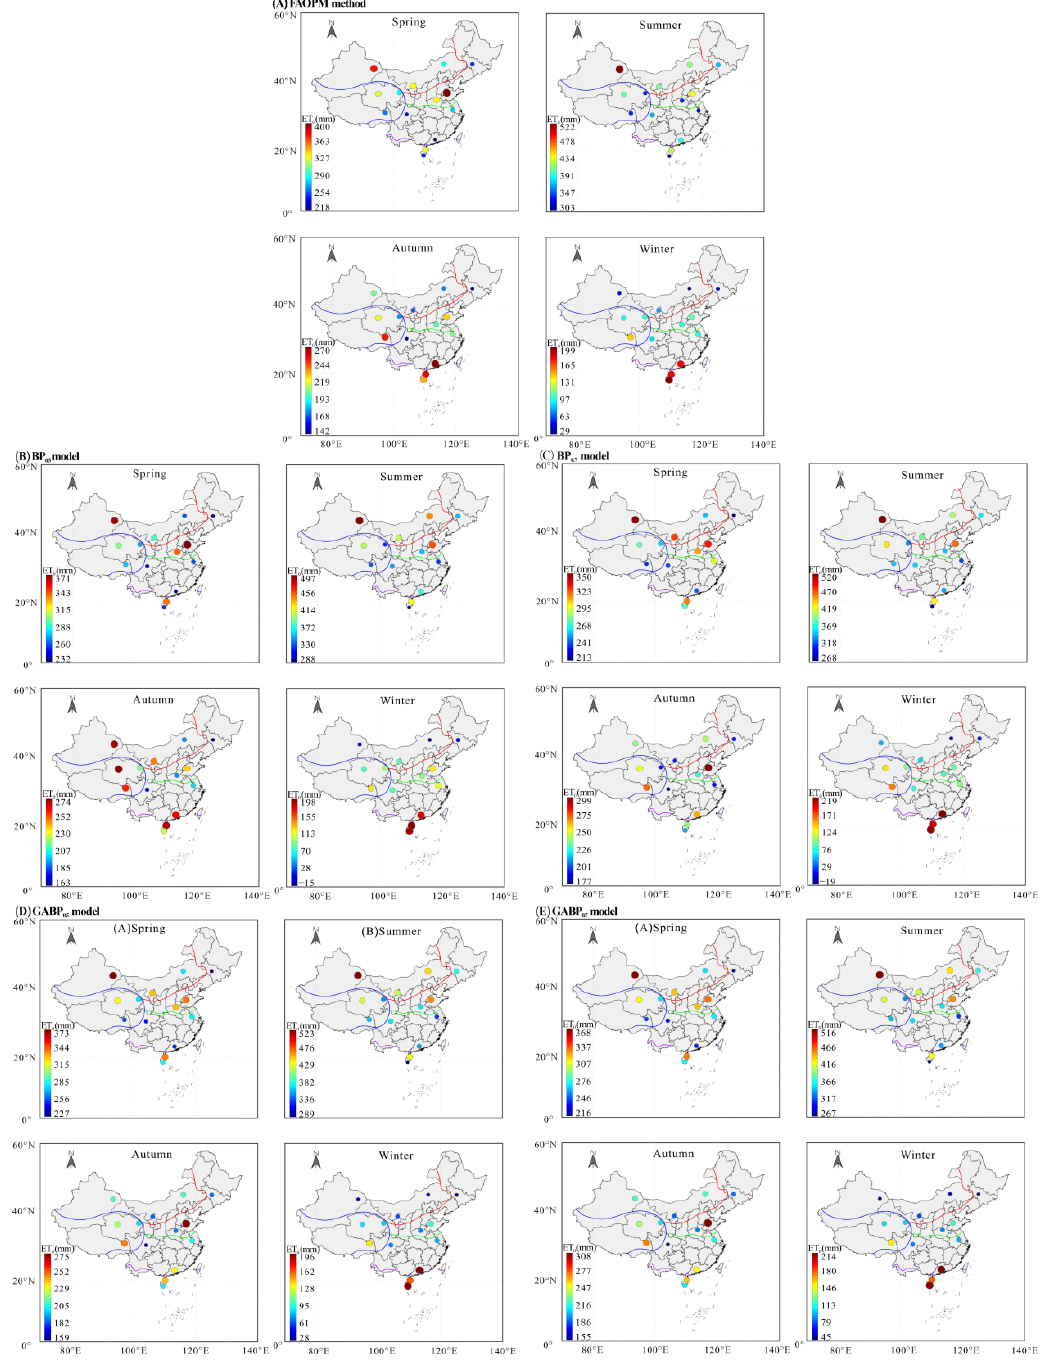
Figure 5. Spatial distribution of seasonal ET 0 in testing phase predicted by ( A ) FAO PM method, ( B ) BP 0.5 , ( C ) BP 0.7 , ( D ) GABP 0.5 and ( E ) GABP 0.7 models for the 14 national meteorological stations in China.